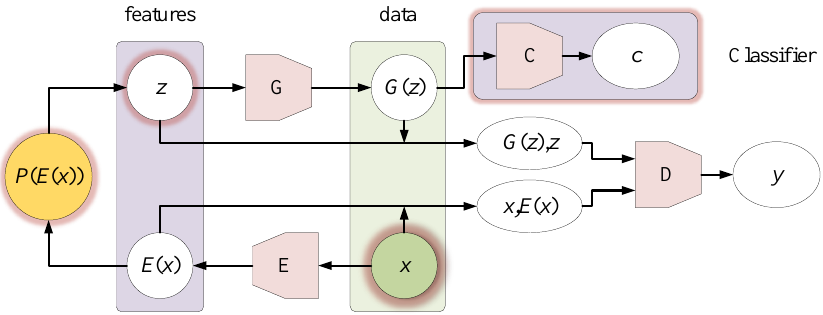
Figure 8. The modification of the original Bi-GAN. This is also the main design of this